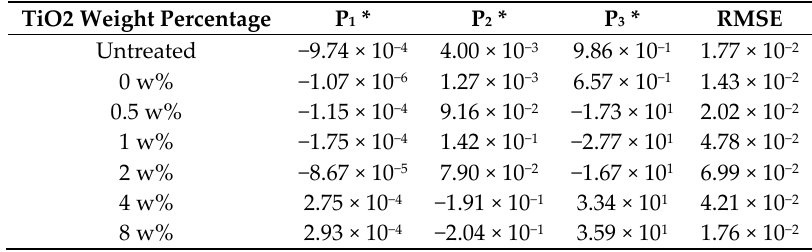
Table 1. Parameters of the fitting models by quadratic polynomial functions.